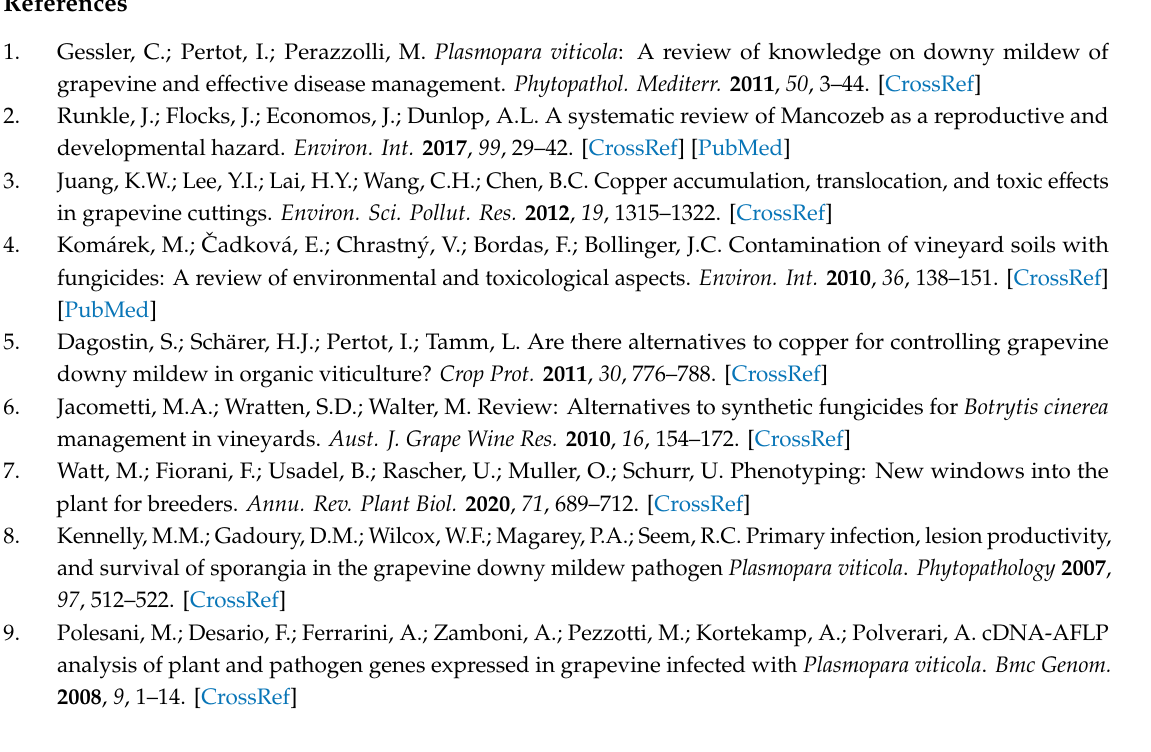
Table S1: Raw data of relative